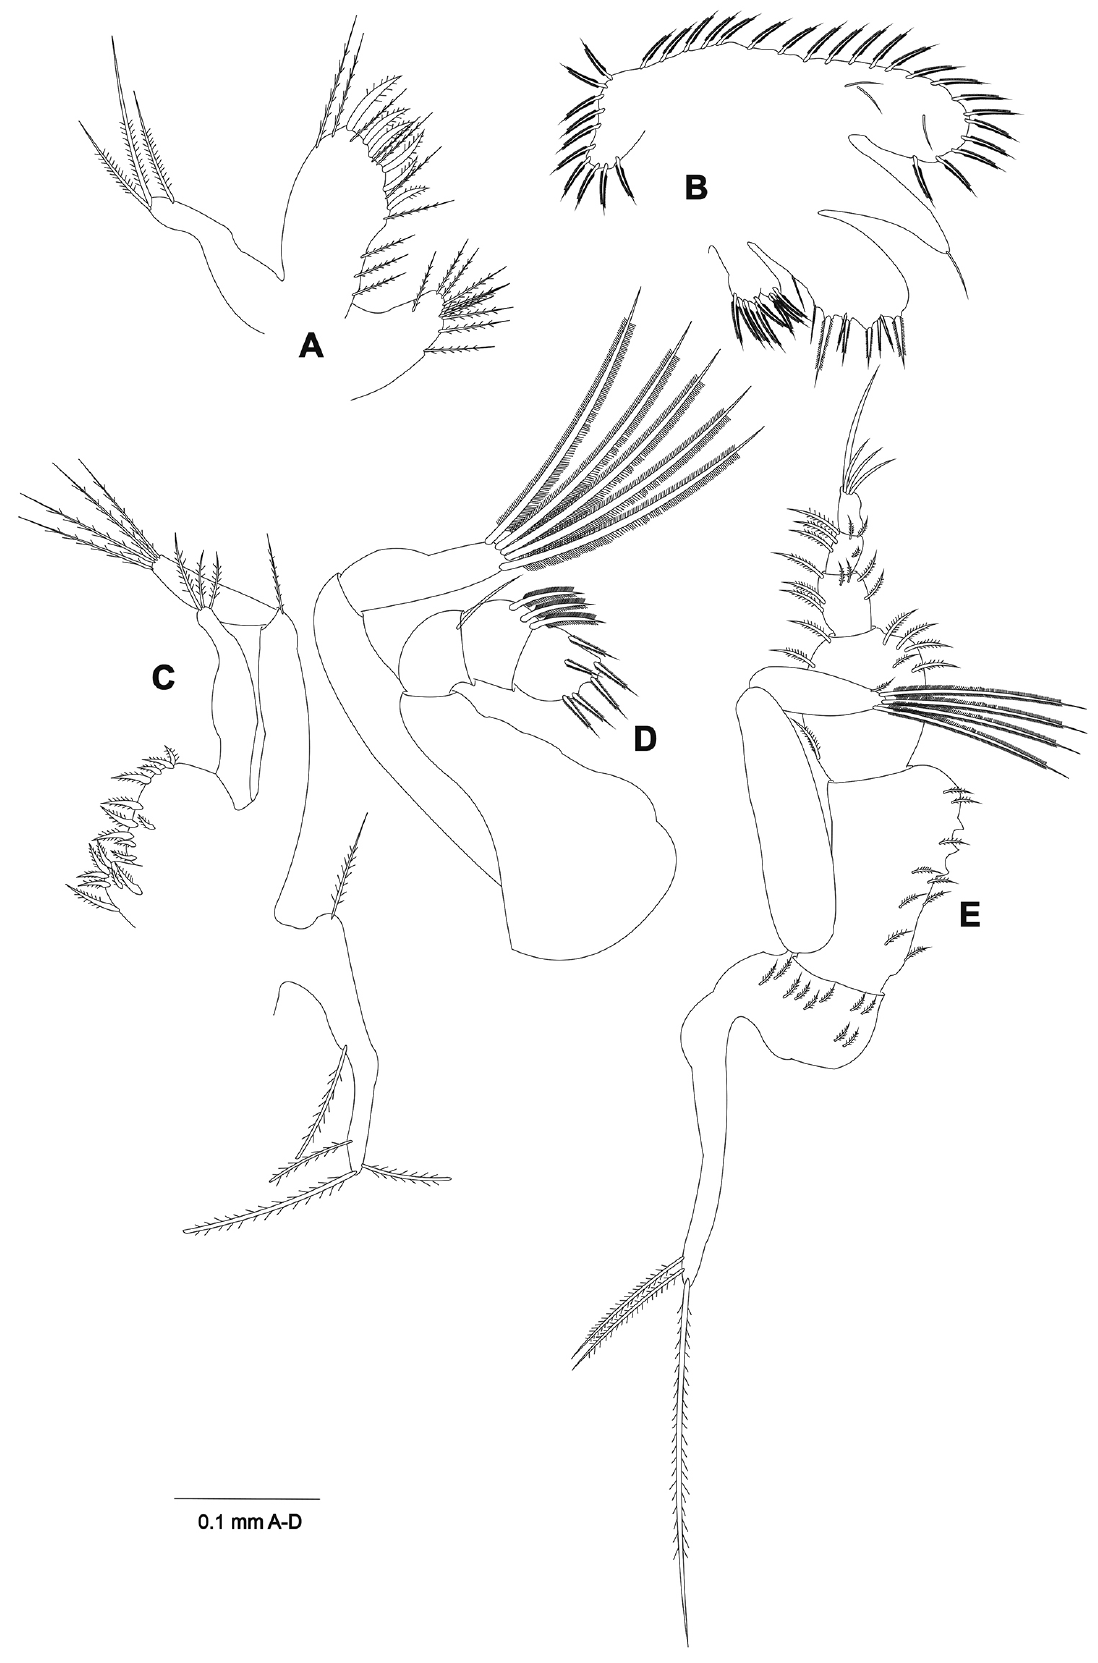
Figure 6. Libinia rhomboidea megalopa. ( A ) Maxillule; ( B ) maxilla; ( C ) first maxilliped; ( D ) second maxilliped; ( E ) third